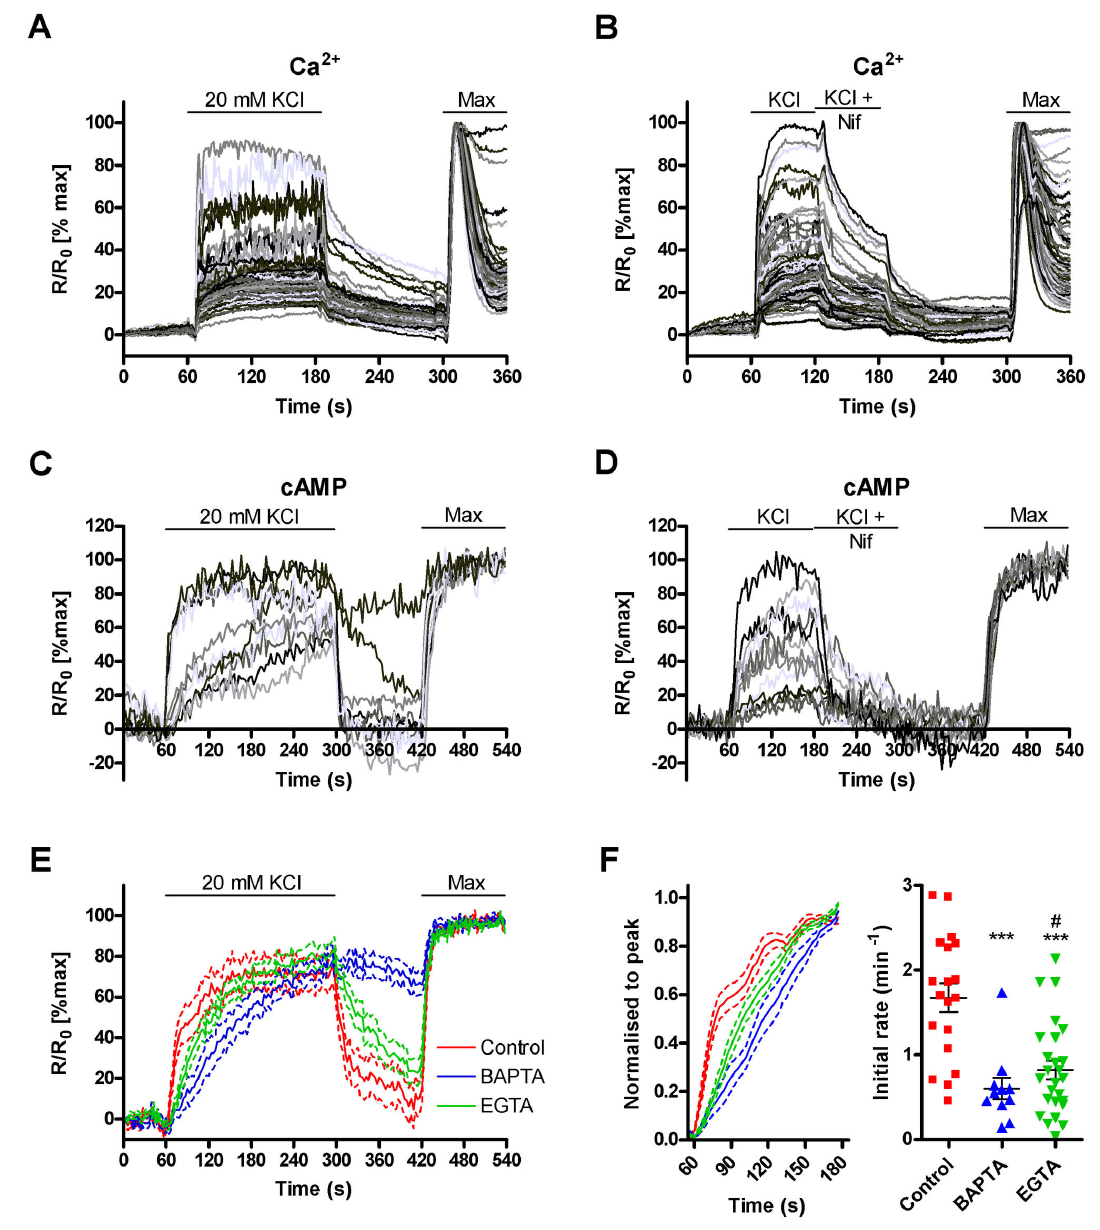
Figure 4. Ca 2+ entry through VGCCs in MIN6 activates AC8. ( A ) Ca 2+ measurements in fura-2 loaded MIN6 cells